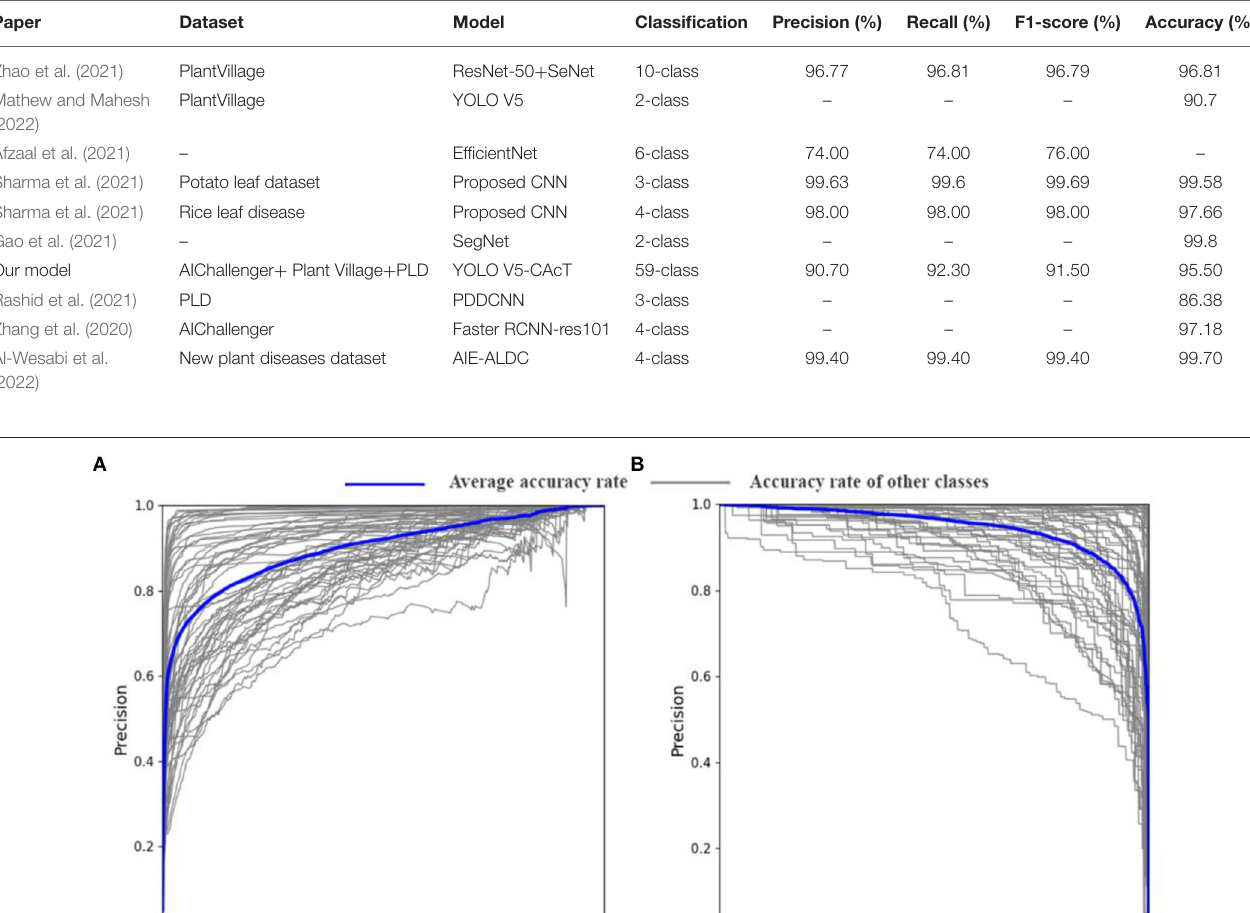
TABLE 7 | Results in the article compared with other state-of-the-art results.